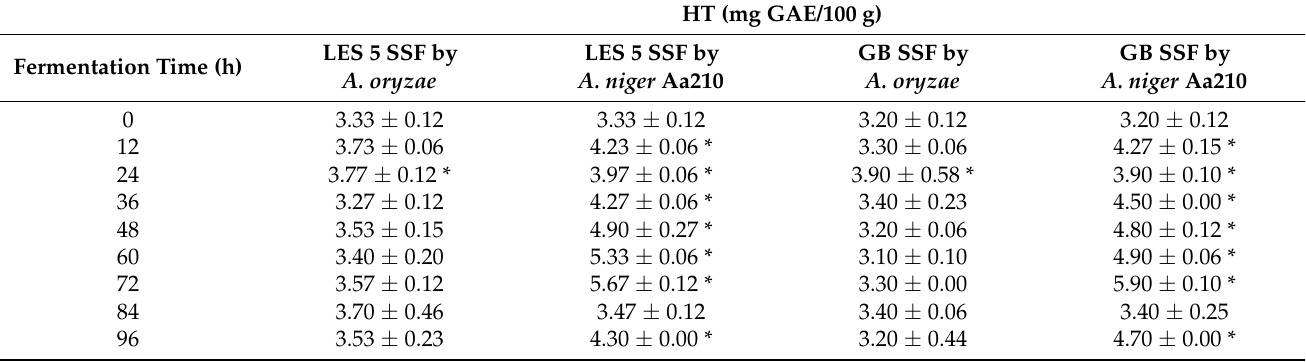
Table 2. Average hydrolyzable tannins (HT) in extracts of LES 5 and GB sorghum during